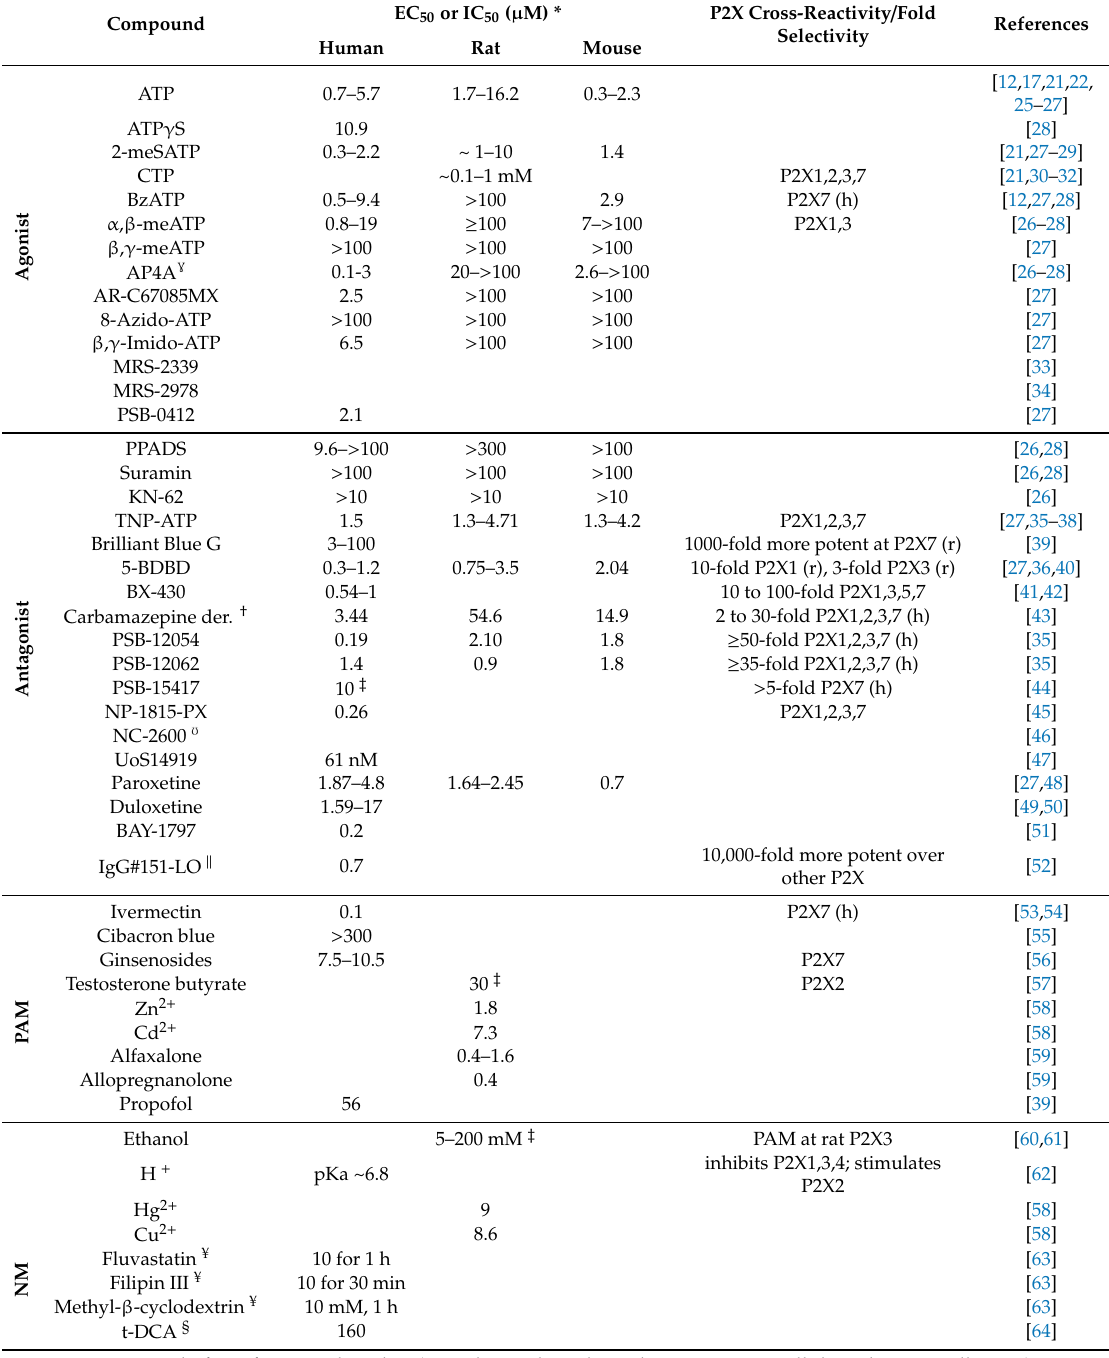
Table 1. Pharmacology of the P2X4